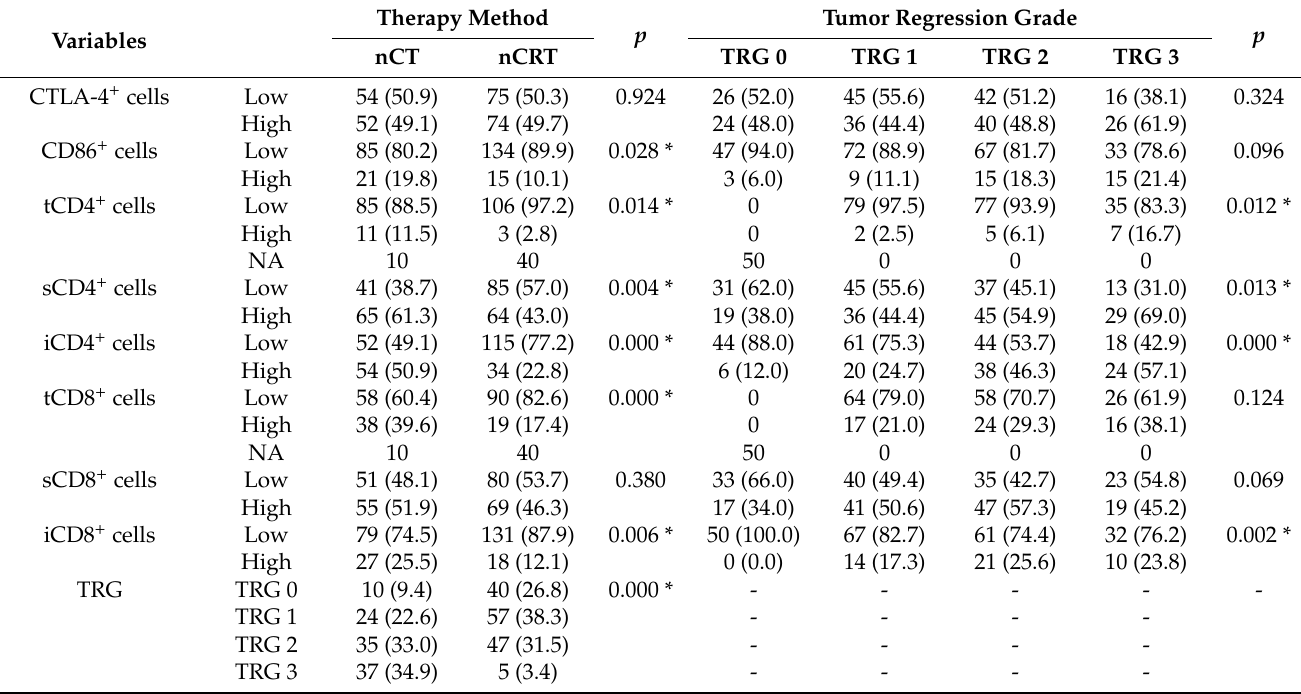
Table 2. Association of immune-related molecules with therapy method and